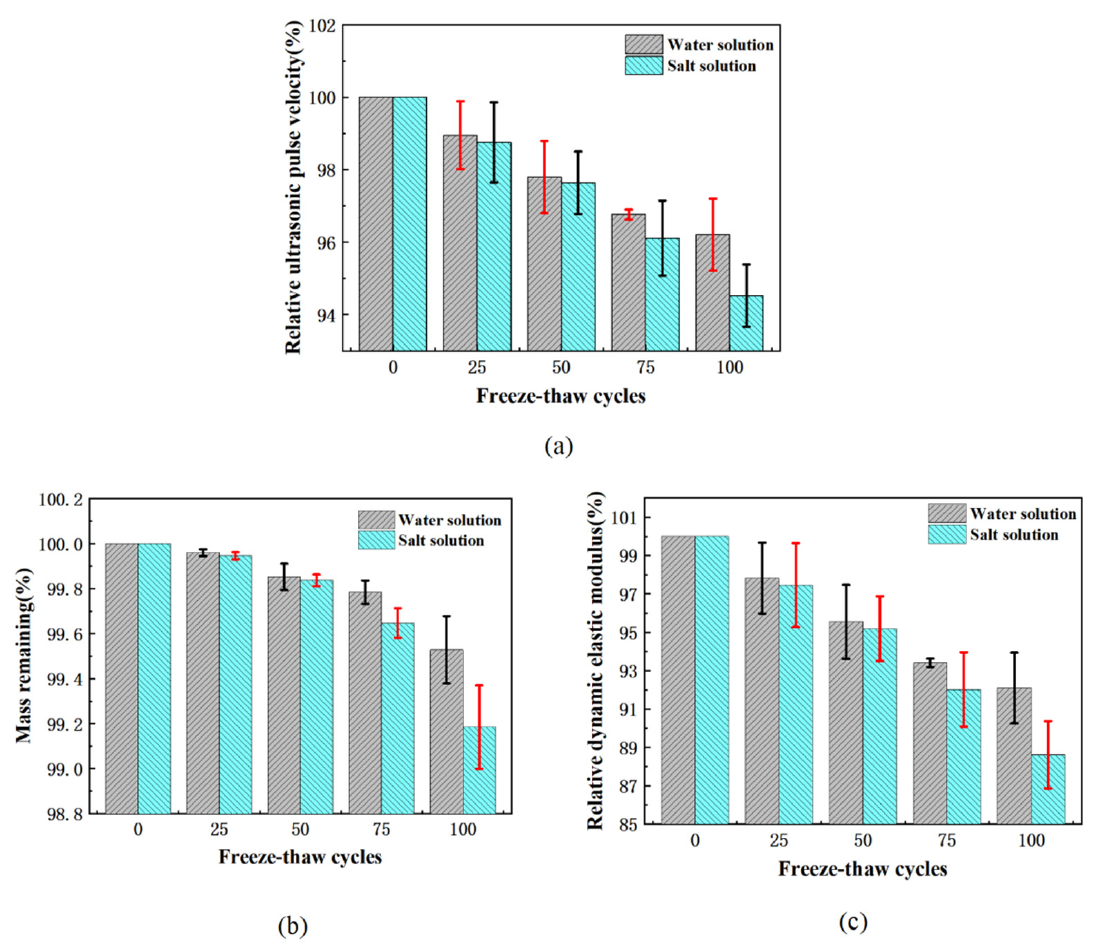
Figure 7. The average index of freeze-thaw durability of permeable concrete ( a ) Relative ultrasonic wave velocity; ( b ) Mass remaining; ( c ) Relative dynamic elastic modulus.